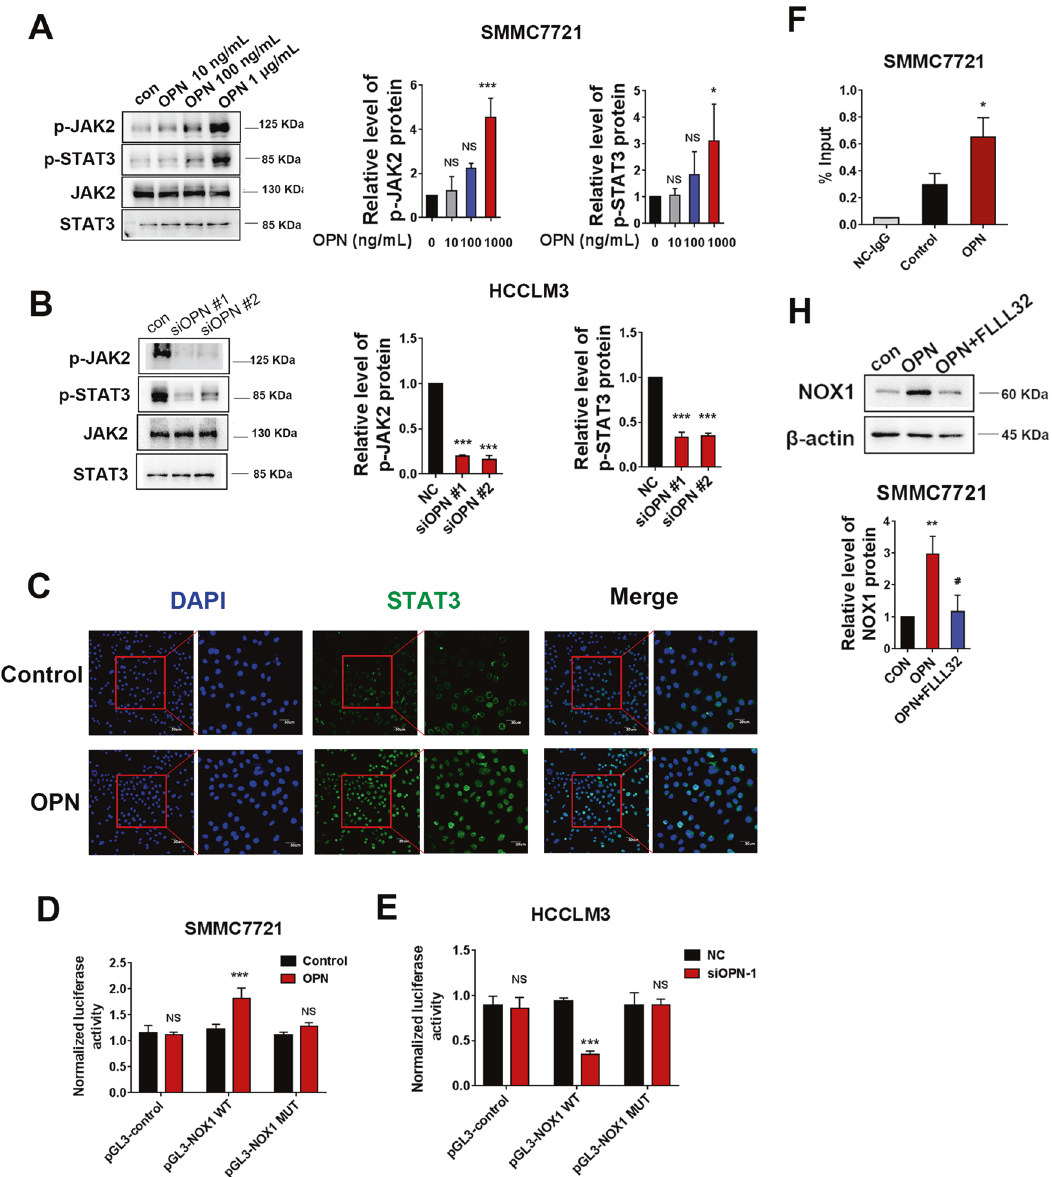
Fig. 4 JAK2/STAT3 signaling plays a crucial role in OPN-induced NOX1 upregulation. Western blot was performed to examine the effect of hOPN treatment (10 ng/mL, 100 ng/mL, 1 μ g/mL) and OPN knockdown on the levels of pJAK2 and pSTAT3 expression ( A , B ). SMMC7721 cells were incubated with PBS or 1 μ g/mL OPN and fl uorescence-stained with STAT3 antibody and DAPI ( C ). The NOX1 promoter construct pGL3- NOX1 ( − 200/ + 1) was transiently co-transfected with pRL-SV40 into SMMC7721 cells treated with OPN or HCCLM3 cells transfected with siOPN. The dual-luciferase activity was determined ( D , E ). CHIP assays in SMMC7721 cells incubated with hOPN or PBS. Chromatin was immunoprecipitated with anti-STAT3 or anti-IgG, and the amounts of precipitated NOX1 promoter fragments were determined by qPCR using the speci fi c primer sets ( F ). The levels of NOX1 protein were analyzed in hOPN treated SMMC7721 cells and hOPN treated SMMC7721 cells after treating them with FLLL32 (10 μ M, 8 h) ( H ). Data indicated mean ± SD. n = 3, * P < 0.05, ** P < 0.01, *** P < 0.001, # Compared with hOPN (Fig. 6C and Fig. S2C). Together, the data demonstrated that NOX1-induced ROS promoted the activation of JAK2/ STAT3 signaling in HCC cells. SMMC7721 and HCCLM3 cells were pre-transfected with NOX1 siRNA followed by hOPN treatment. As shown in Fig. 6D and Fig. S2D, hOPN treatment substantially activated the JAK2/ tumor growth rate, tumor size, and tumor weight (Fig. 7A – C). STAT3 pathway, whereas siNOX1 could partially reverse OPN- There were no signi fi cant changes in body weight of the mice, mediated JAK2/STAT3 activation in these cells. These results indicating that shOPN did not affect eating or drinking behaviors showed that NOX1 increased JAK2 and STAT3 phosphorylation by of tumor-bearing mice during treatment (Fig. 7D). To fi gure out producing ROS, amplifying JAK2/STAT3 signaling induced by OPN.